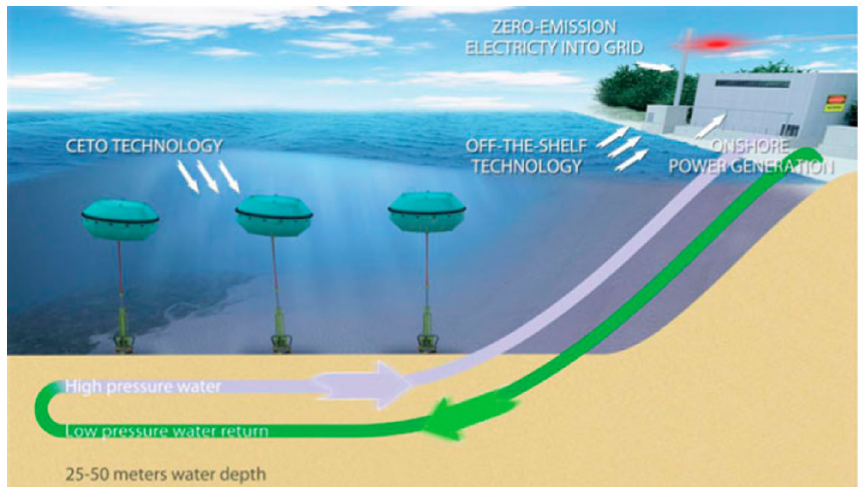
Fig. 39 The combined system consisted of CETO technology and DPP (Viola et al.